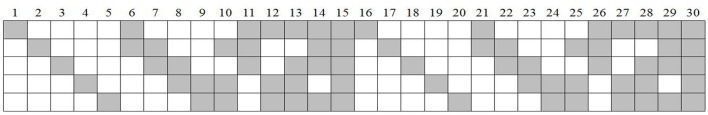
Q'-matrix for 30 items and 5 attributes in the simulation study. Blank means 0 and gray means 1; the first 15 items are used when I = 15.